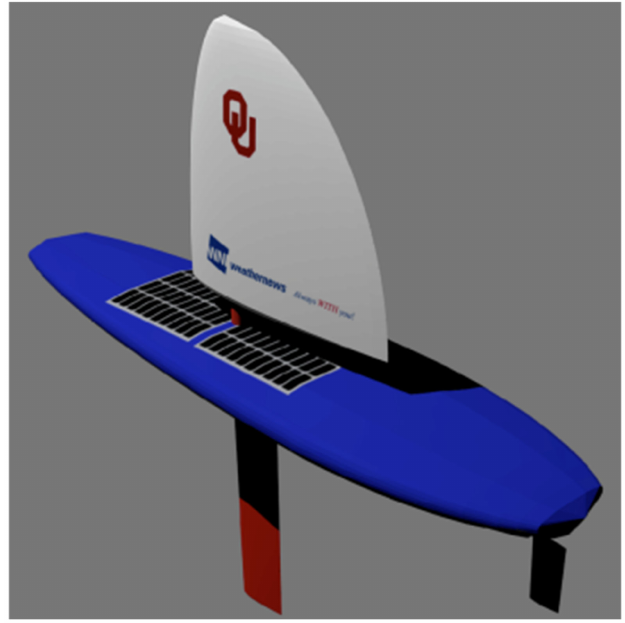
Figure 1. First generation of MURON instrument prototype designed by the intelligent aerospace radio team at the University of